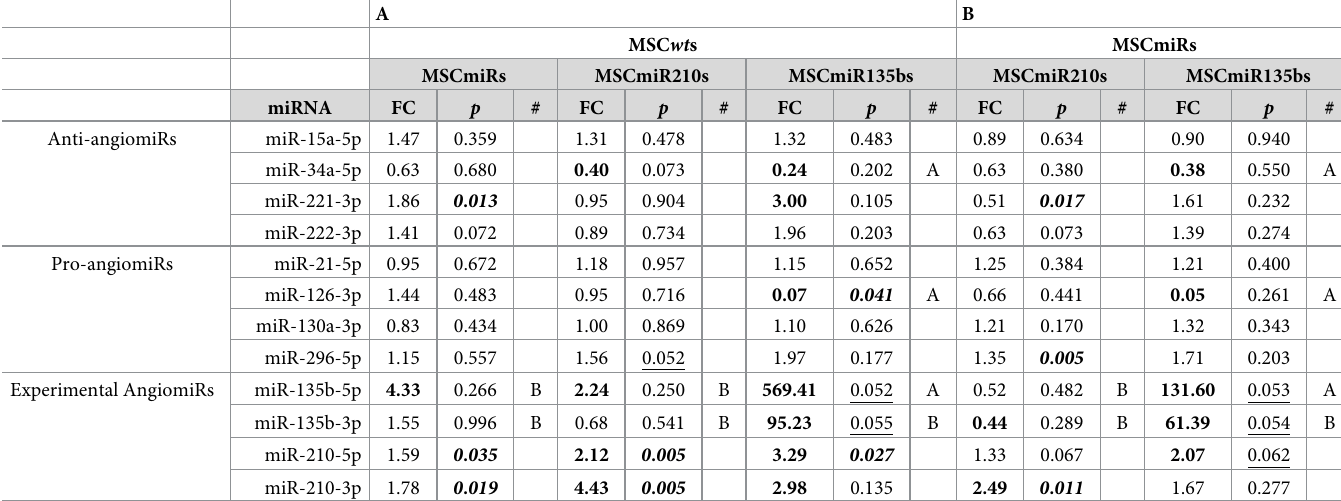
Table 2. miRNA expression in modified MSCs compared with that in MSC wt s and MSCmiRs (control cells).